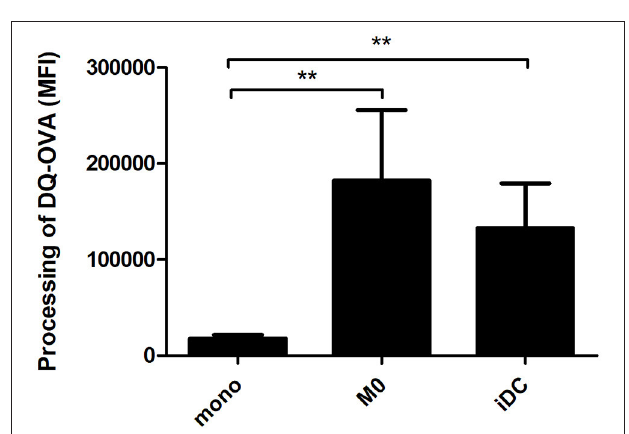
FIGURE 6 | THP-1-derived macrophage- (M0) and dendritic-like cells (iDC) revealed a significantly increased capacity to process antigens compared to monocytes. Proteolytic cleavage of fluorophores from DQ-OVA (initially auto-quenching due to heavily labeling) result in fluorescent signals. THP-1 monocytes were non-treated or differentiated into M0 and iDC and incubated with DQ-OVA for 2h, after which the florescence signal was measured by flow cytometry. The results represent the average MFI ± SD of 5 independent experimental measurements. The statistical differences between any two data set were calculated with two-tailed unpaired T -test, ** p <